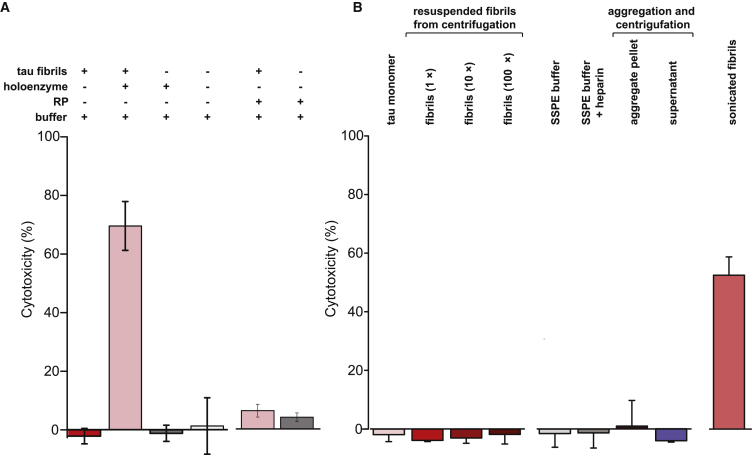
Fragmented Species Trigger Cell Lysis(A) A lactate dehydrogenase (LDH) assay was used to detect lysis of HEK293 cells after incubation with either intact aggregated tau (column 1), the fragmented species (column 2), the buffer alone (column 3), or proteasome holoenzyme alone (column 4). Cells were tested for levels of lysis after incubation with fibrils treated with free RP (column 5) or with free RP alone as a control (column 6).(B) Aggregation buffers and tau fibrils are not toxic to cells. Monomers (column 1) or fibrils (column 2–4) at 1-, 10-, and 100-fold (10× and 100×) of the incubation concentration in (A) were incubated with the cells. Several controls including sodium chloride-sodium phosphate-EDTA (SSPE) buffer alone (column 5), SSPE buffer containing heparin (column 6), the pellet (containing tau fibrils, column 7), or the supernatant fraction (containing soluble aggregates and monomers, column 8) after centrifugation (STAR Methods) were also tested for cell lysis. As a positive control (column 9), fibrils were sonicated briefly and centrifuged to separate insoluble fibrils so that the supernatant could be added to cells at the same calculated concentration.Error bars represent SD of measurements from the mean of three independent experiments (n = 3).